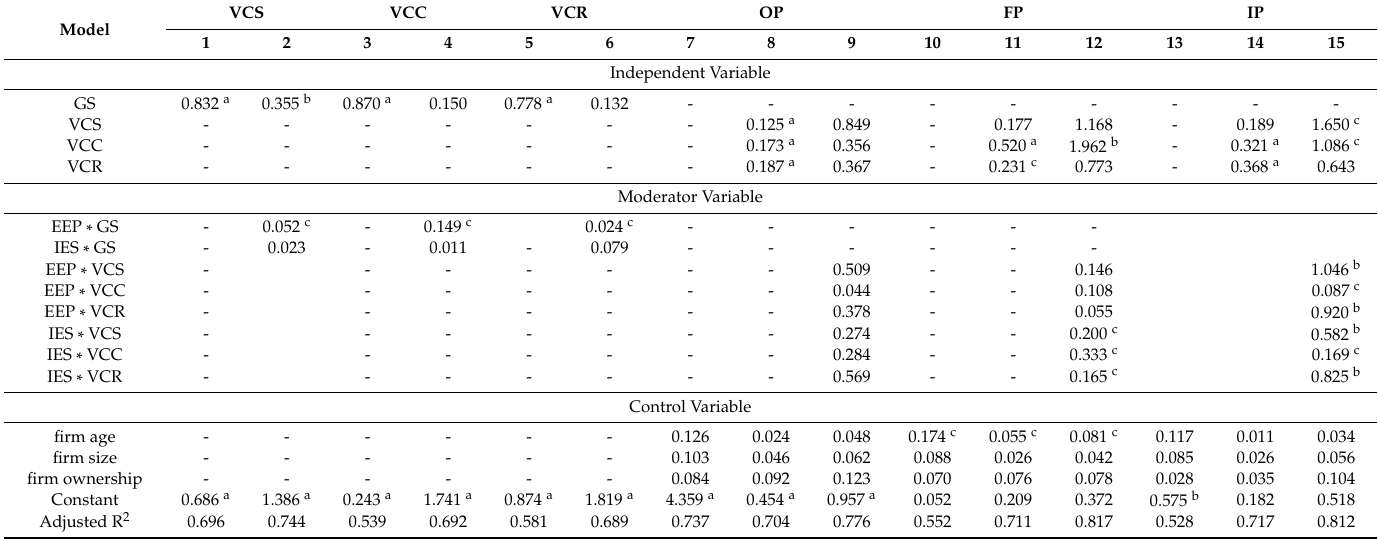
Table 5. Result of hierarchical regression